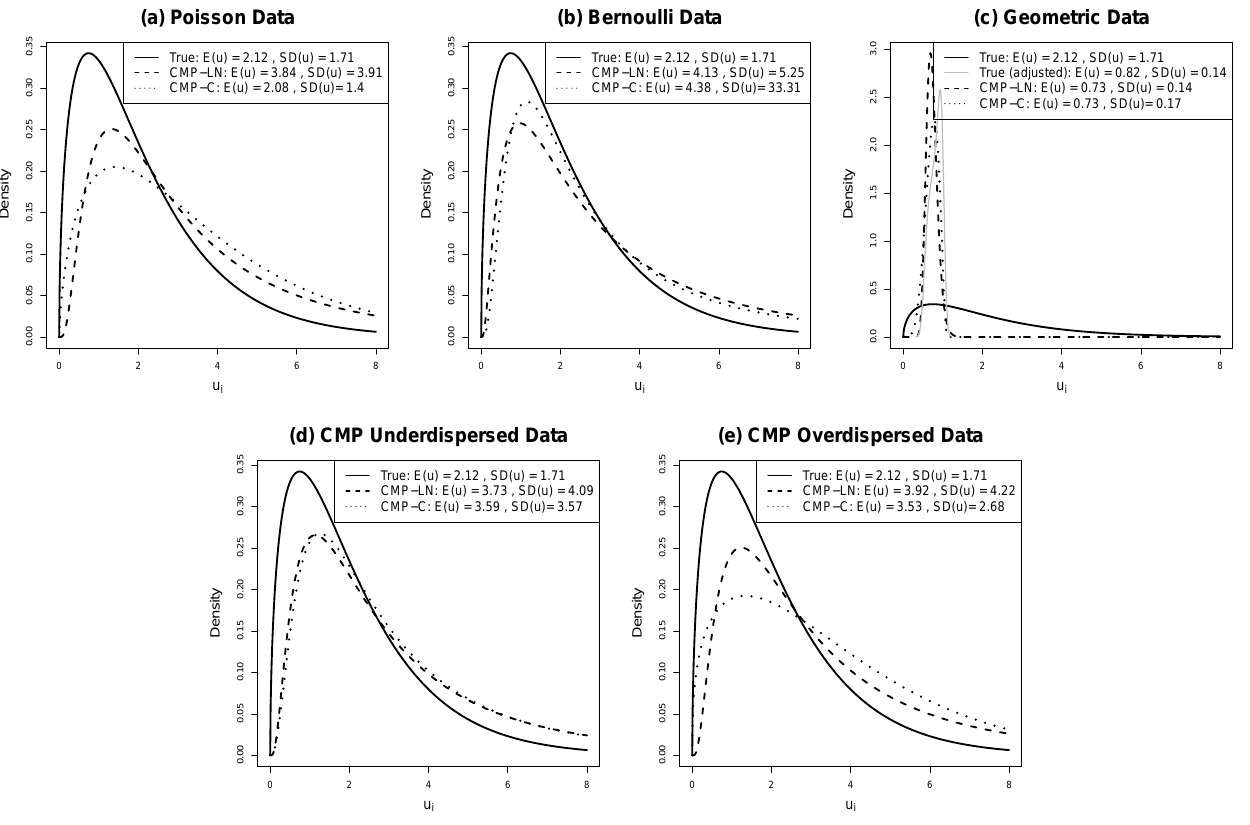
Figure 4. Lognormal and conjugate densities evaluated at ˆ θ estimated in CMP-LN and CMP-C models for Scenario II simulated data. Mean and standard deviation for estimated density are calculated from moment expressions for the lognormal distribution and empirically from moment definitions for conjugate